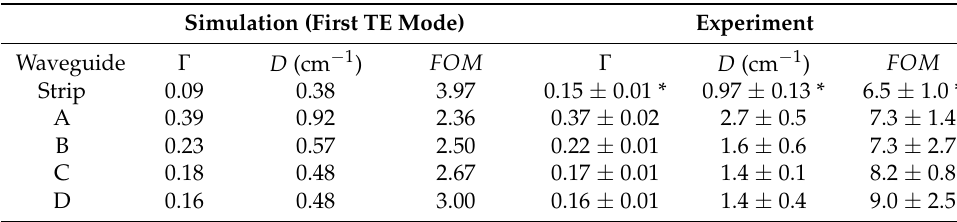
Figure 4. Simulation results of ( a ) 𝐷 and ( b ) 𝛤 for the CSA waveguides and comparison with the experimentally determined values for the structures in Table 1. Simulations are reported as circular points connected by lines. Experimental points are squares. Associated error bars are ±s. The colors of the simulation and experimental points are consistent: blue ( g = 300 nm), orange ( g = 400 nm), and red (strip waveguide). The experimental values of the strip waveguide are taken from Reference [14]. The point at w = 0.8 μ m, marked as a cross, is taken from Reference [24]. Table 2. Values for the parameters 𝛤 , 𝛤 , and 𝐹𝑂𝑀 were retrieved by the simulations for the fun ‐ damental quasi ‐ TE mode, and their corresponding measured values. Four chips were measured for each type of waveguide.